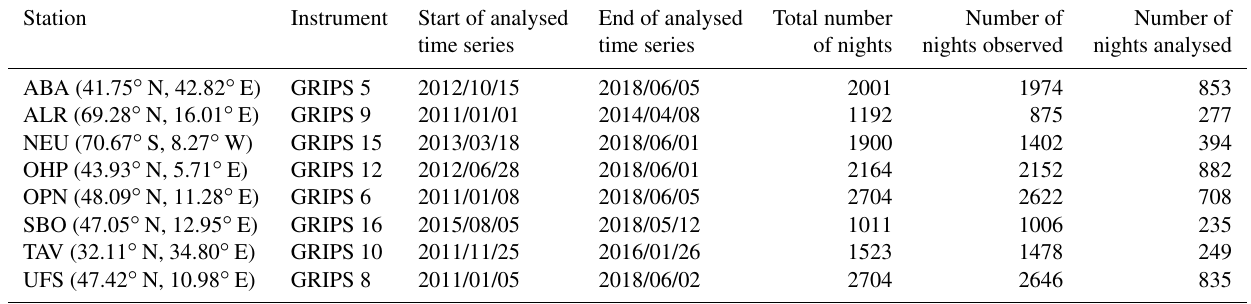
Table 1. Start and end dates of the analysed time series for the respective stations. The same start dates as in Wüst et al. (2016, 2017a) have been chosen for each data set as far as the respective stations have been analysed. Date format: YYYY/MM/DD. Station Instrument Start of analysed End of analysed Total number Number of Number of time series time series of nights nights